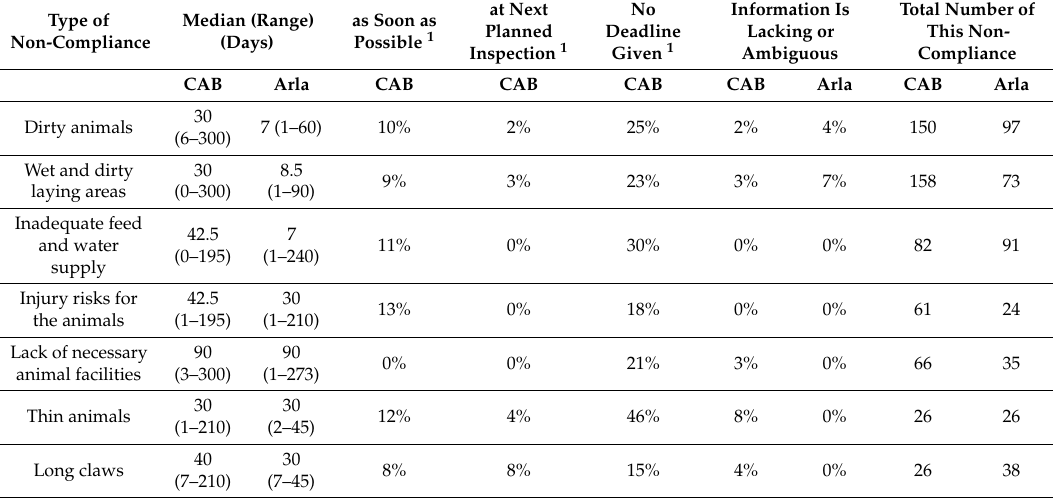
Table 4. Time periods given for correction of the seven most common non-compliances found in both official animal welfare control (CAB = County Administrative Board) and Arlagården private standard audits (Arla) in the Swedish county of Västra Götaland during 2010–2013. The periods were calculated from the first time the specific non-compliance was observed.